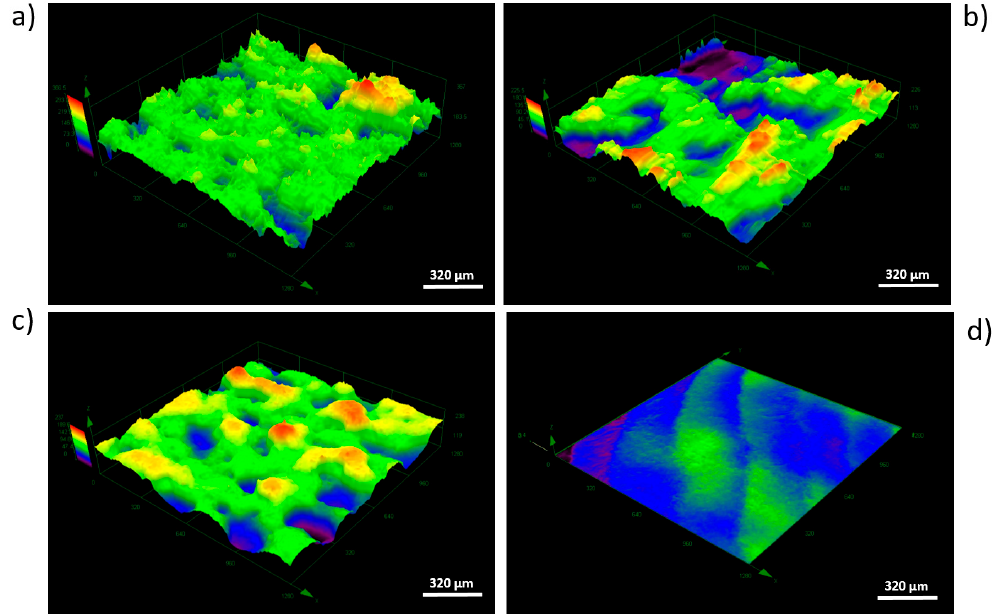
Figure 5. Overview of 3D surface maps for selected area (dimetric projection) obtained by four types of surface modifications: ( a ) As-built, ( b ) acid-etched, ( c ) sandblasted, ( d ) machined (area of 1280 µ m × 1280 µ m), CM.